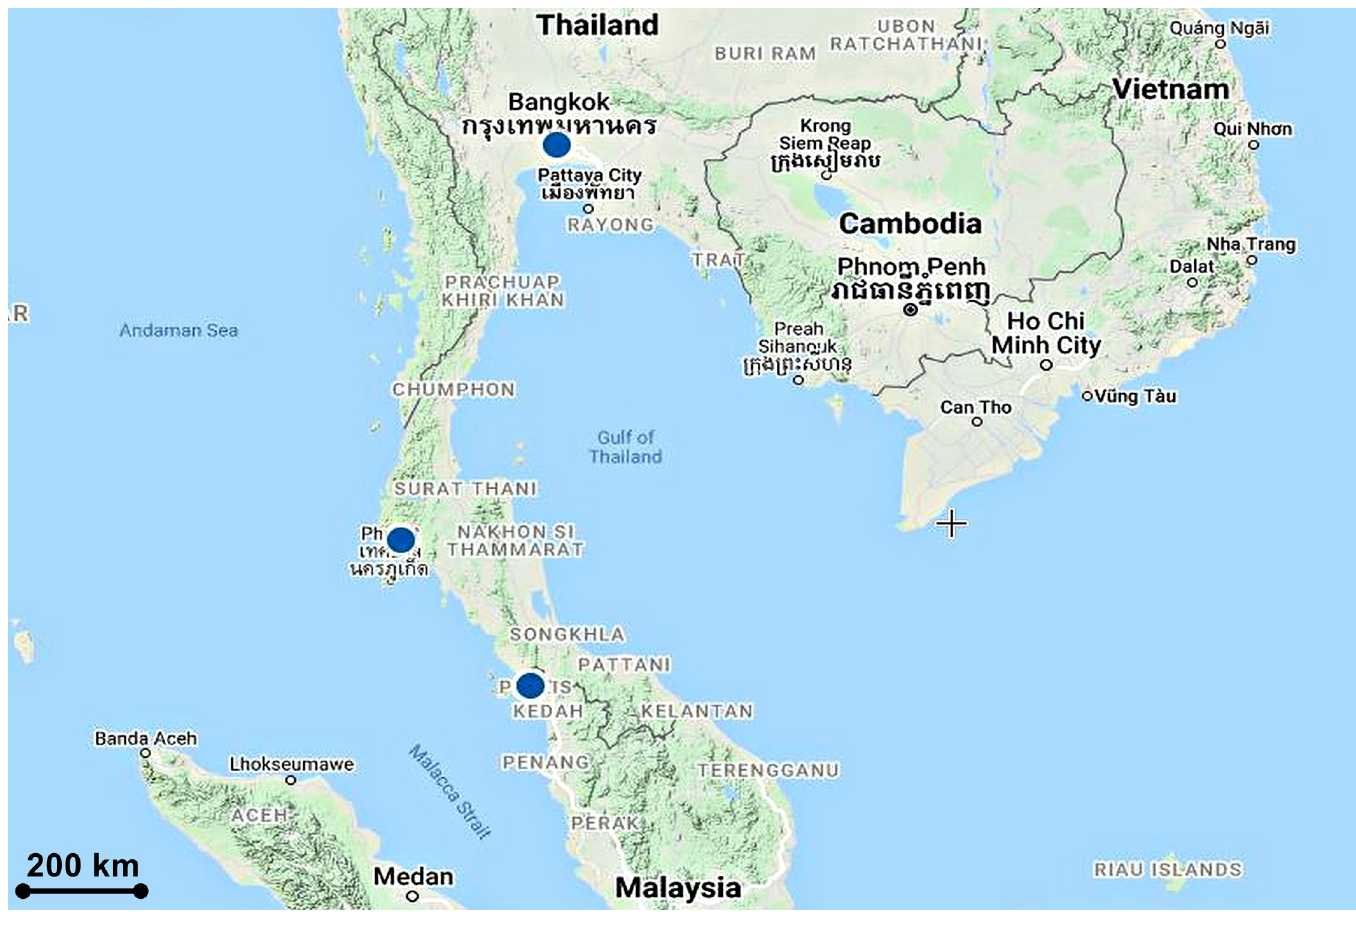
Fig 2. Distribution of Paphiopedilum exul .